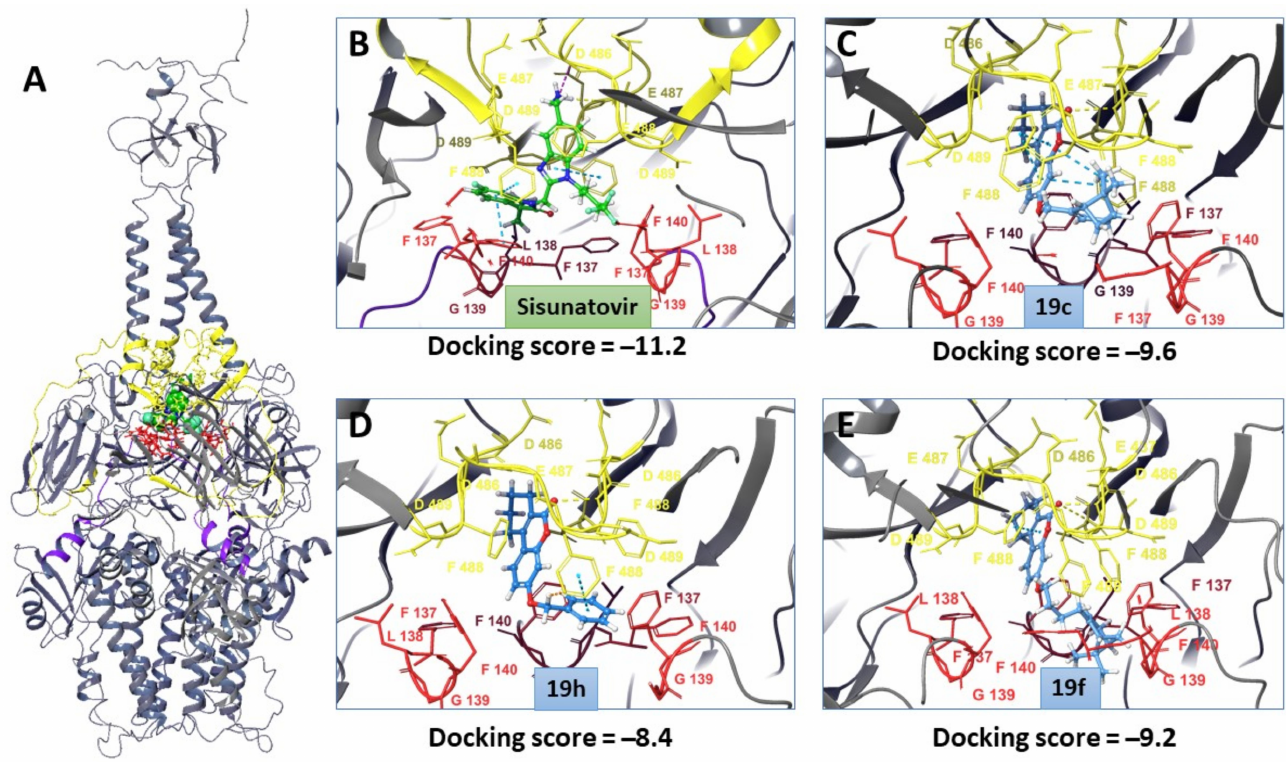
Figure 3. Structure of the RSV F-protein: ( A ) structure corresponds to PDB [40] code 7LVW [39]: fusion peptide region is presented in violet secondary structure (137–157 amino acids); functional residues (137–140) are shown in red; amino acids of the membrane anchor are shown in yellow (amino acids 454–499); the green molecule is sisunatovir [15]; ( B ) sisunatovir in the binding site; ( C – E ) positions of possible entry inhibitors ( 19c , 19f , and, 19h ). π – π stacking interactions are denoted by blue dotted lines; H-bonds and salt bridges are denoted by yellow and violet lines,